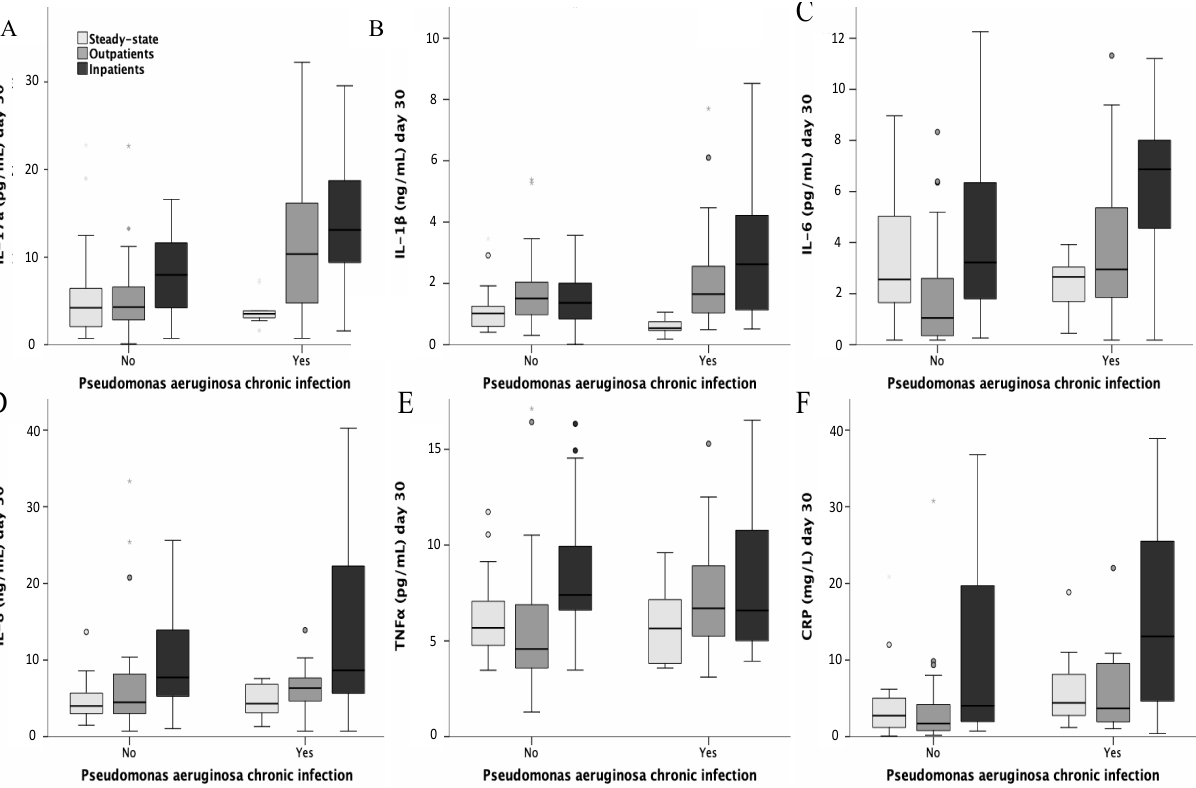
Figure 4. Systemic inflammatory cytokine and hsCRP levels at 30 days by exacerbation severity and chronic PA infection. Boxplot shows the levels of systemic inflammatory cytokines and hsCRP at 30 days in patients with severe and non-severe exacerbations by the presence or absence of chronic PA infection. The box line represents the median, while the boxes include the 25th to 75th percentile. The whiskers span the minimum and maximum values. Points are values that the statistical program automatically considers outliers. ( A ) IL-17a; ( B ) IL-1 β ; ( C ) IL-6; ( D ) IL-8; ( E ) TNF- α ; ( F ) hsCRP. Abbreviations: hsCRP, high-sensitivity C-reactive protein; PA, Pseudomonas aeruginosa